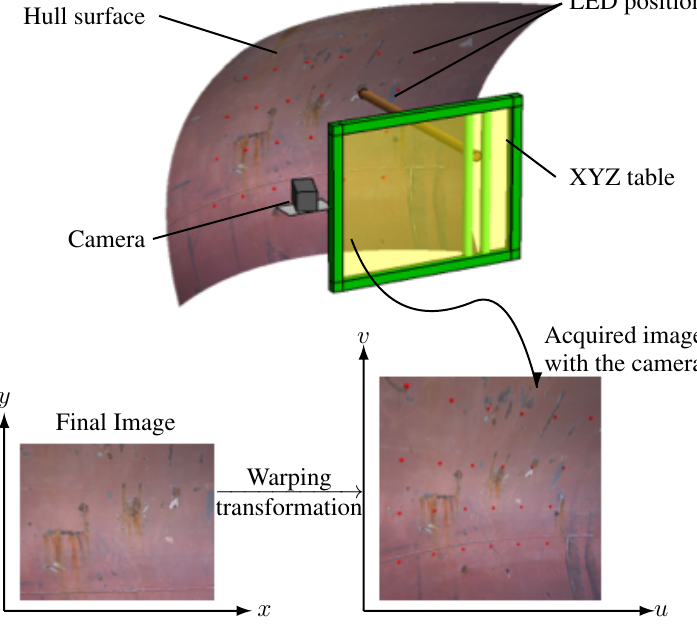
Figure 11. Diagram with all the elements that take part in Warping